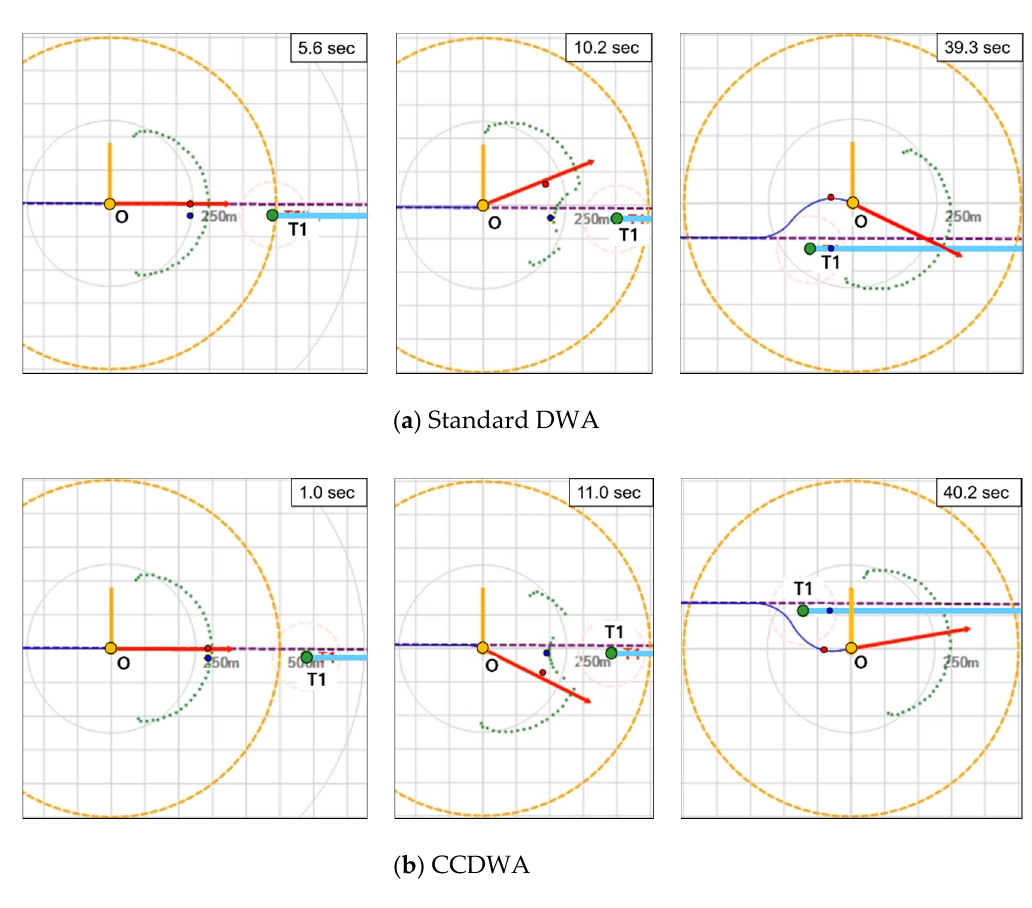
Figure 7. Simulation in a head-on situation with a dynamic obstacle: an orange dot is our own ship, a green dot is the obstacle ship, a blue line is our own ship’s trajectory, a light blue is the obstacle’s trajectory.